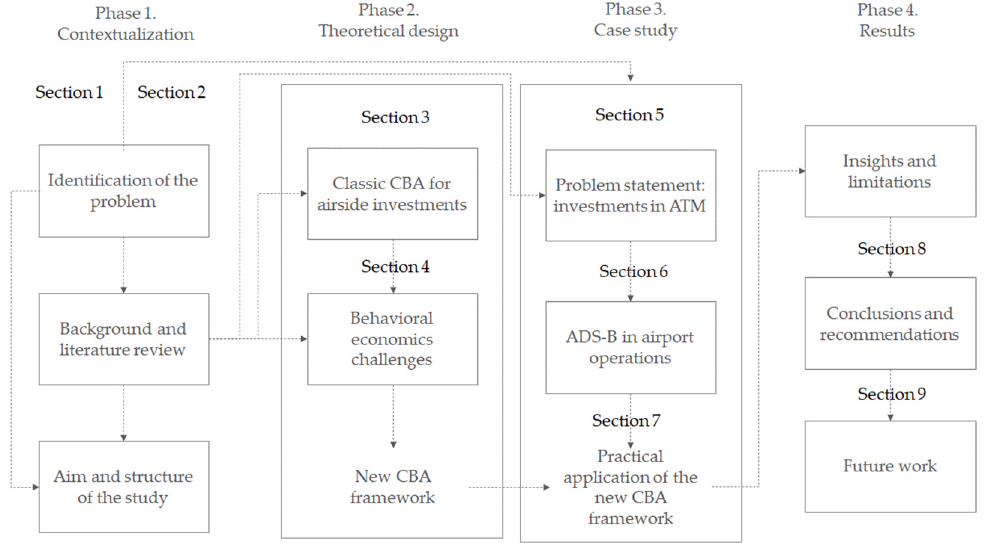
Figure 1. High-level methodological approach for the paper.